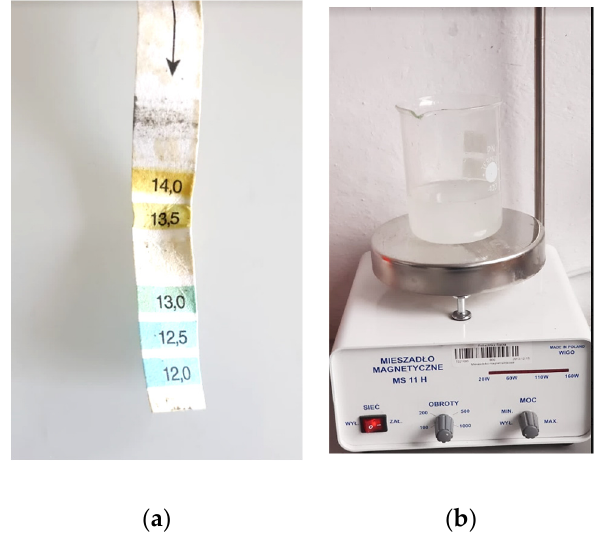
Figure 3. ( a ) The view of pH-value of fresh geopolymers; ( b ) alkaline solution in magnetic stirrer. In the case of geopolymer mortar, normalised sand according to EN-196-1 was used in an amount of 1350 g.